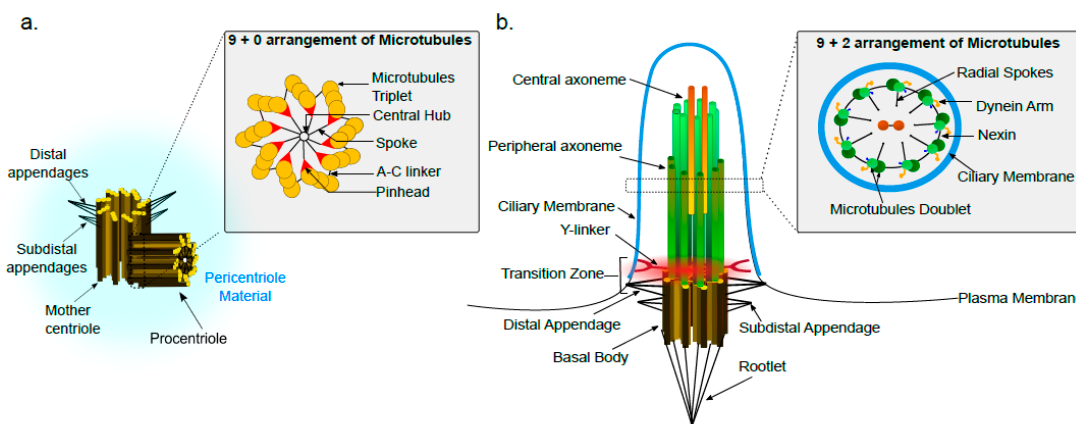
Figure 1. Schematic representation of ( a ) centrosome highlighting the 9 + 0 arrangement of triplet microtubules (box) and ( b ) a cilium showing 9 + 2 arrangement (motile cilium) of doublet microtubules (box). The major features of the centrosome/cilium are marked. The mother centriole triplets are extended into cilia doublets. The C-tubule extends into the transition zone of the cilium which is also decorated by the Y-fibers.